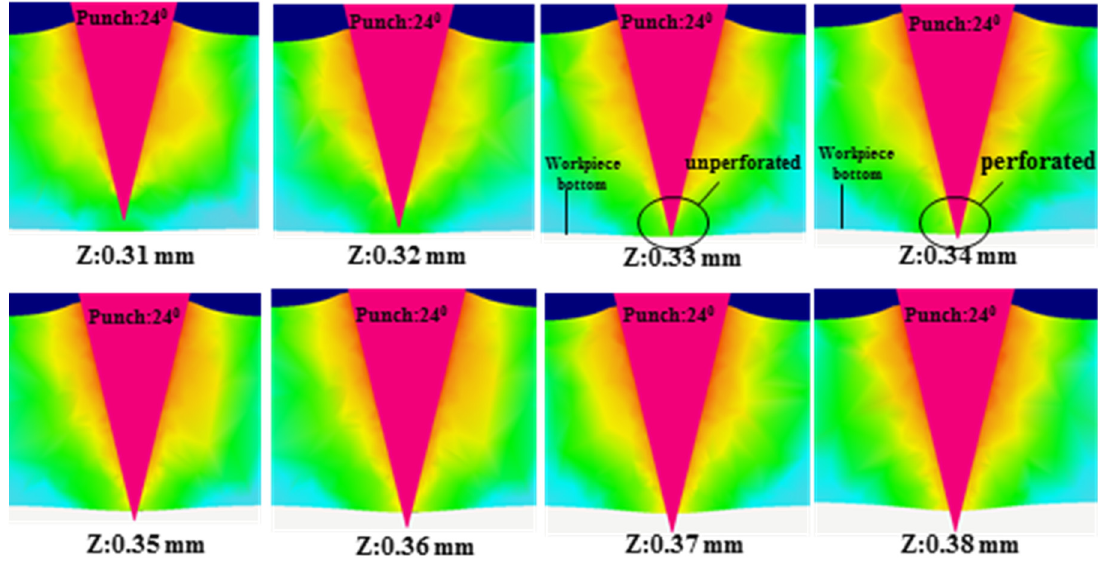
Figure 6. Stamping depth/punch forming relationship simulation analysis.